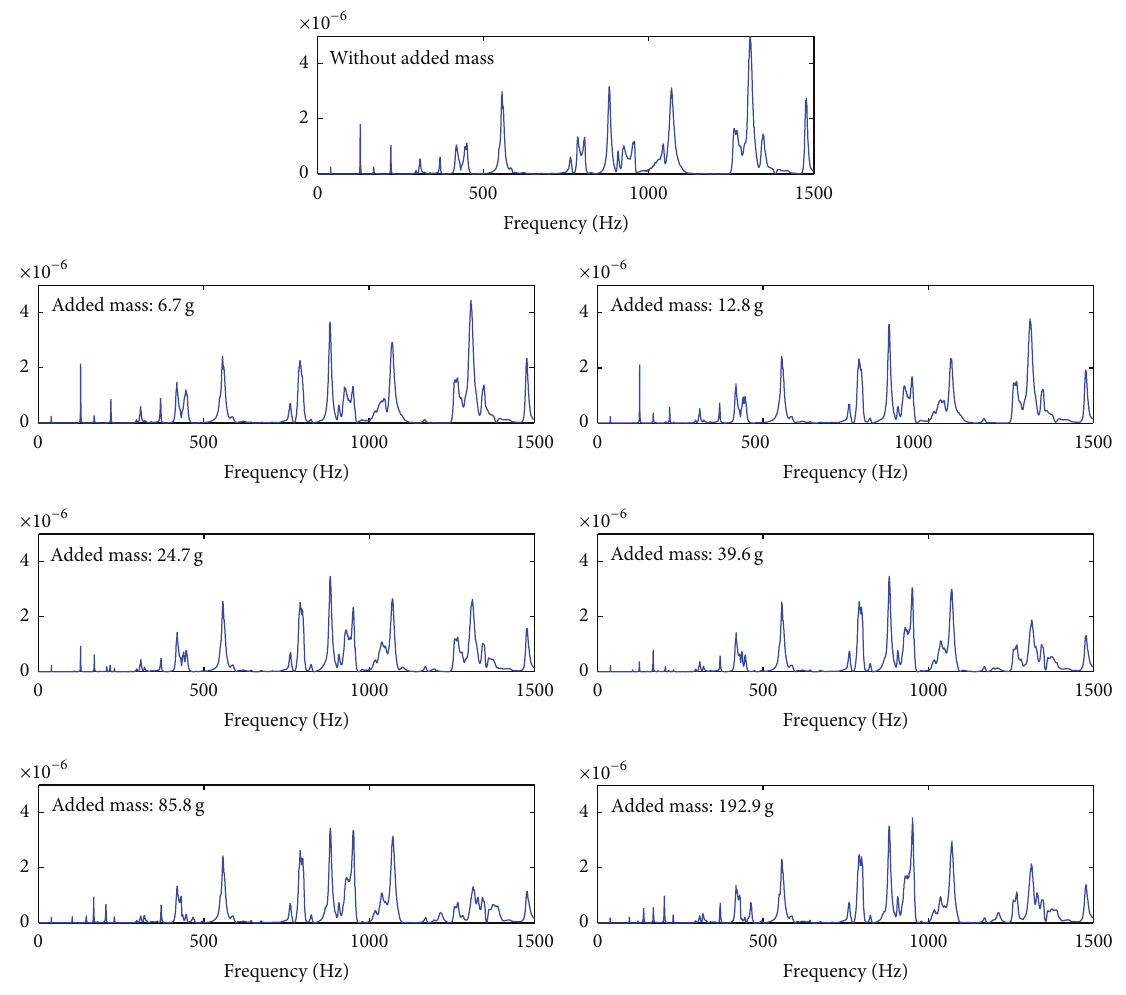
Figure 4: Examples of experimental FRFs. The examples correspond to the sensor 1 with the damage in position P1. In the figure, the added mass is